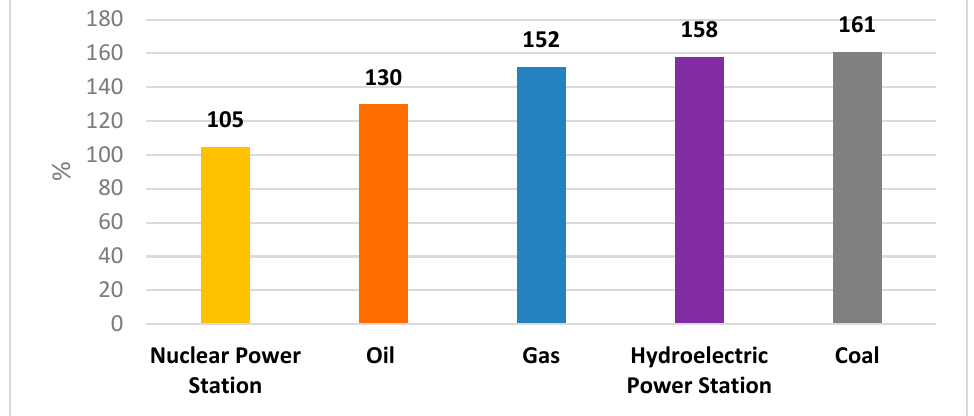
Figure 1. Growth in primary energy production from 2000 to 2018. Adapted with permission from Ref. [1].